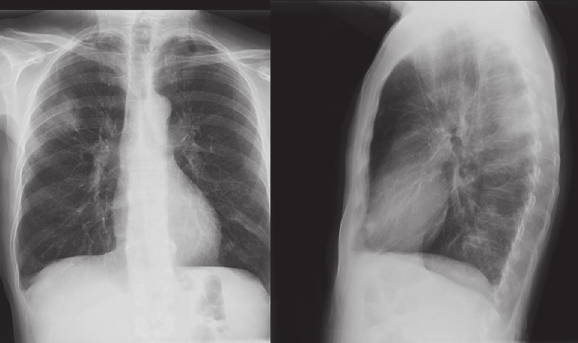
Figure 3: Chest X-ray showing a triangular consolidation in the right superior